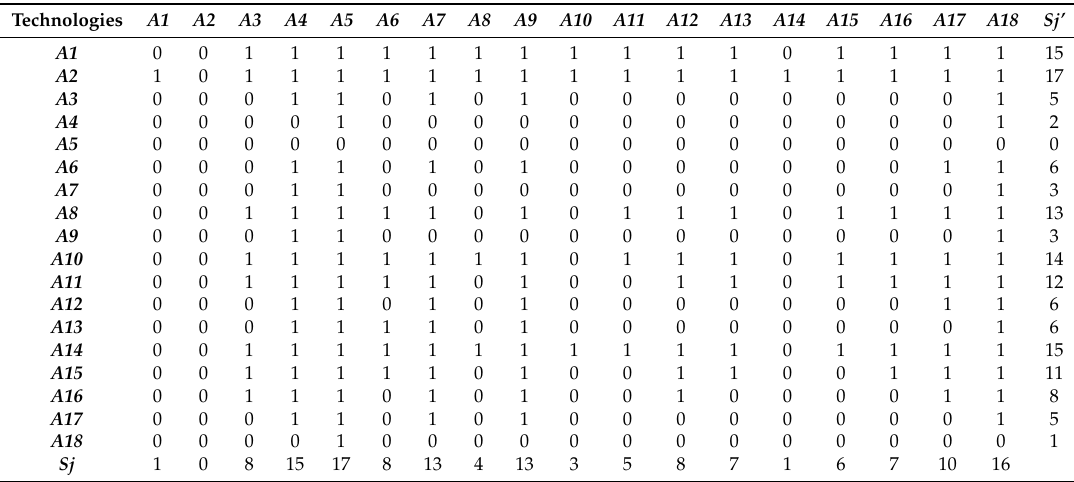
Table 9. N × N matrix used in Borda ranking